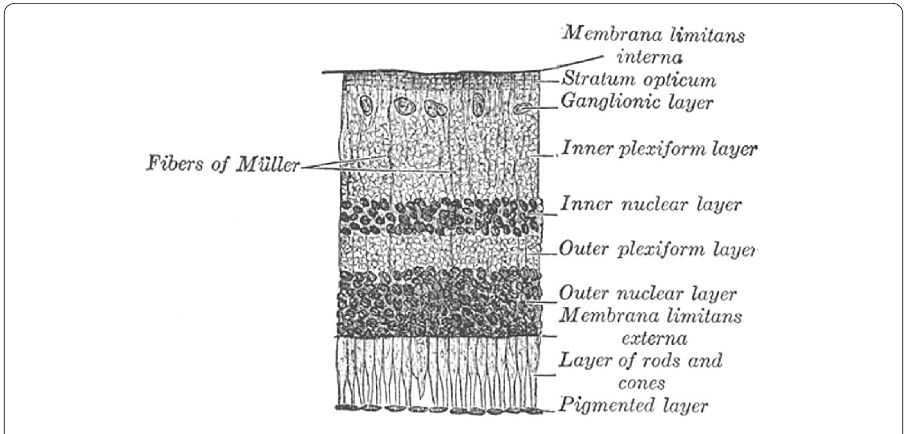
Figure 1 Section of the retina. Henry Gray. Anatomy of the Human Body. Philadelphia: Lea & Febiger, 1918. (in public domain at Bartleby.com)